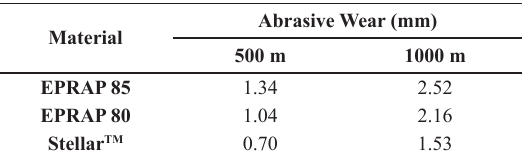
Figure 2. SEM fractographs of the materials EPRAP 85 (a) and EPRAP 80 (b). Table 2. Amsler wearing associated with thickness reduction of EPRAPs and Stellar TM